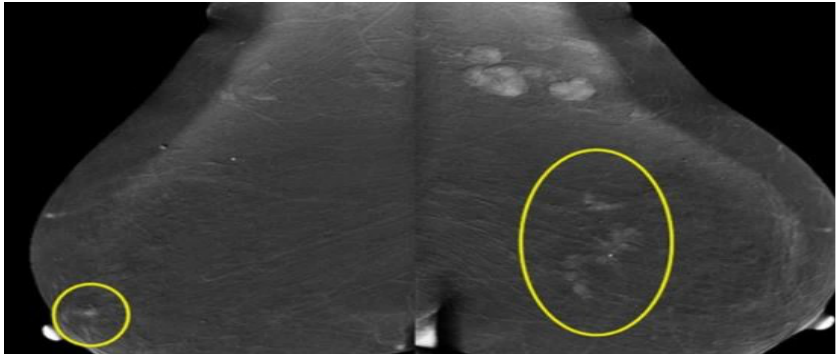
Figure 5. Samples of Mammogram breast image